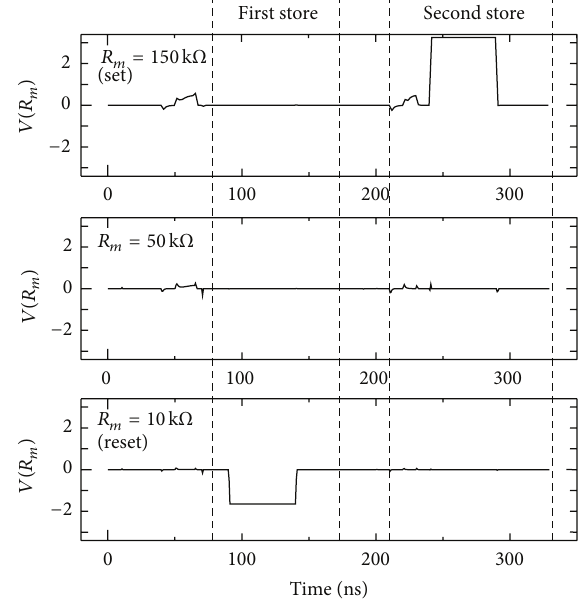
Figure 10: Simulation results for store operation. 𝑅 fixed at 100 and 65 k Ω . In this case, the information “01” was stored in 𝑅 𝑚